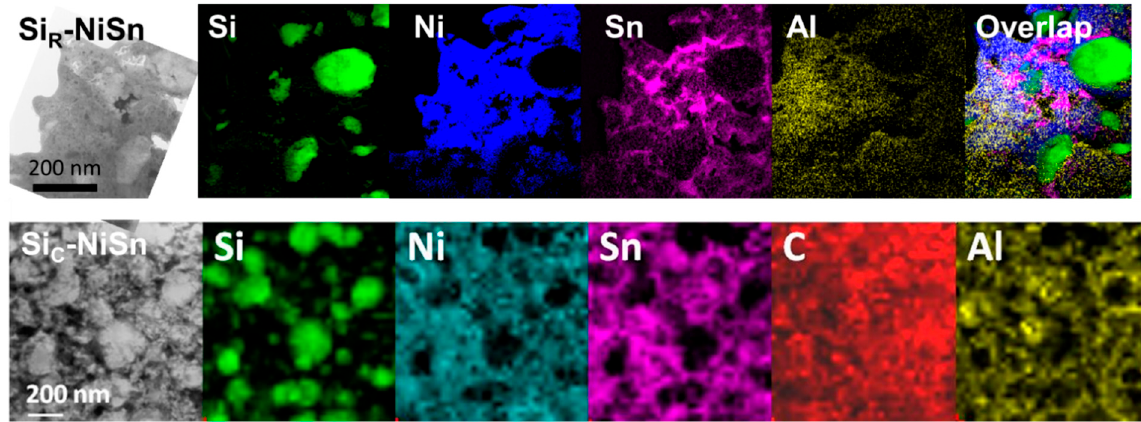
Figure 4. TEM images and elemental mapping for Si R -NiSn (( top ), Electron Energy Filtered Transmission Electron Micros- copy (EFTEM) mapping) Si C -NiSn (( bottom ), STEM-EDX mapping).